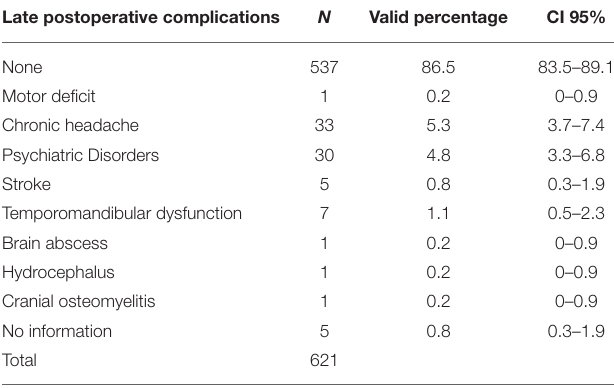
TABLE 5 | Late postoperative